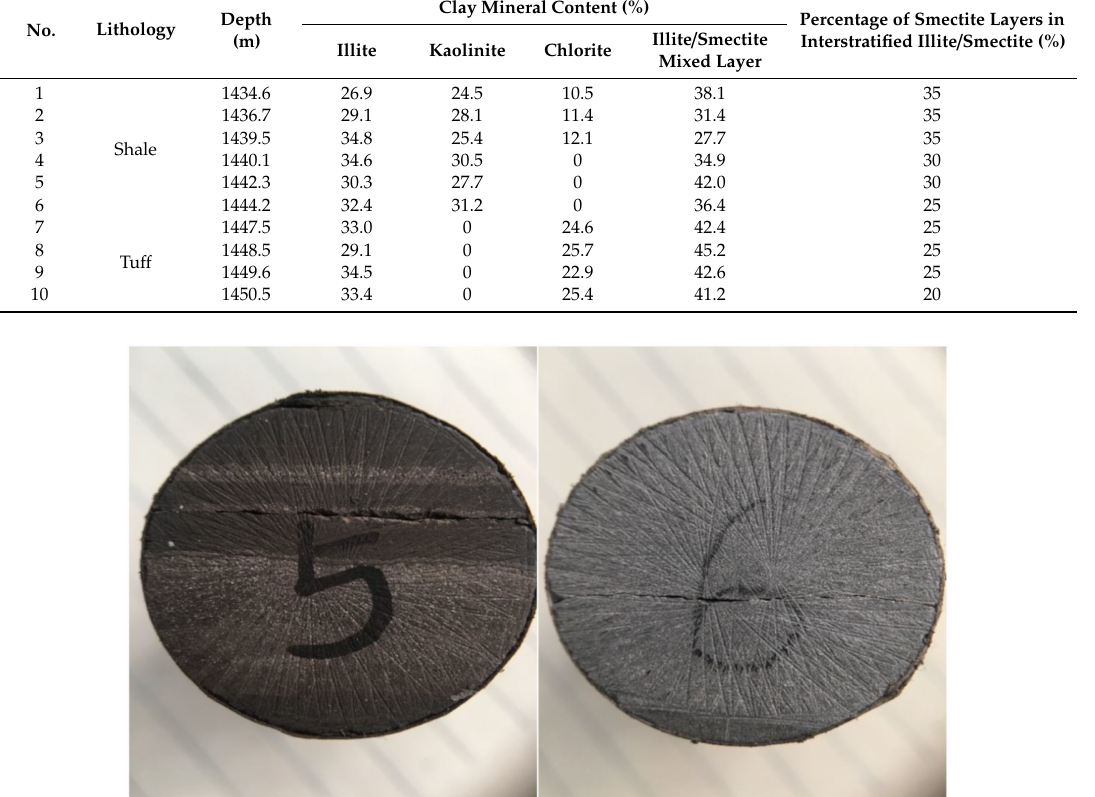
Figure 10. Non-penetrating cracks in the sample, which provide little permeability in the axial